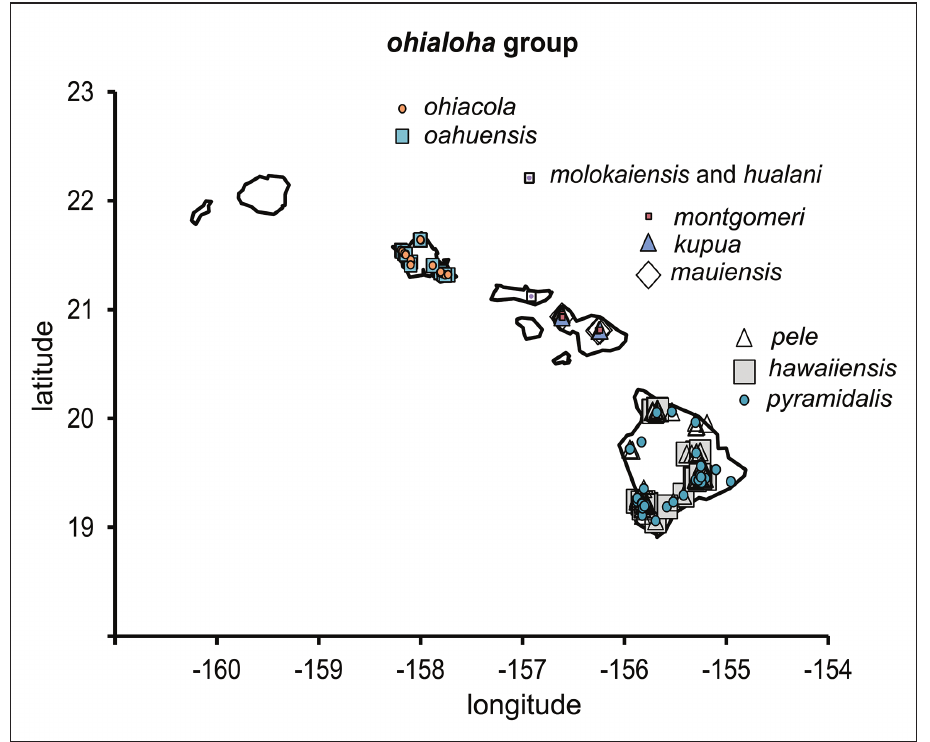
Figure 55. Map indicating sampling sites for ohialoha group.